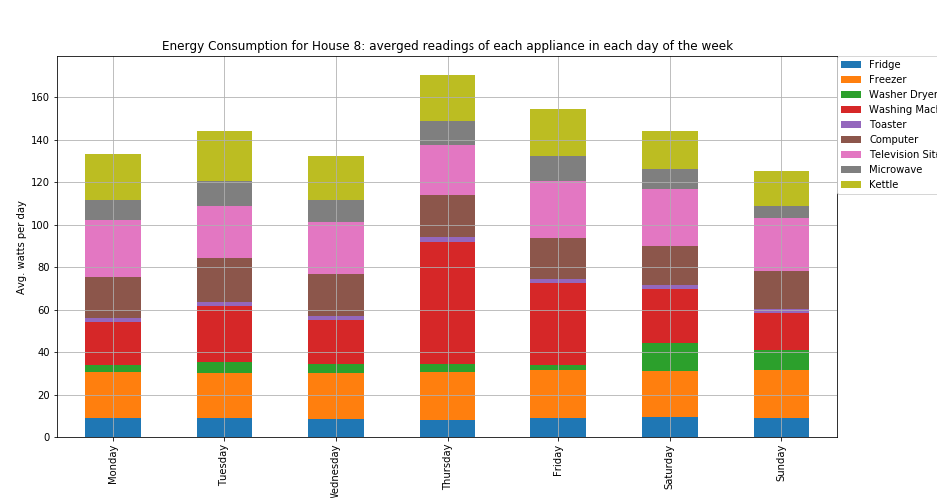
Figure A12. The average consumption per day of home appliances for house 8 with two